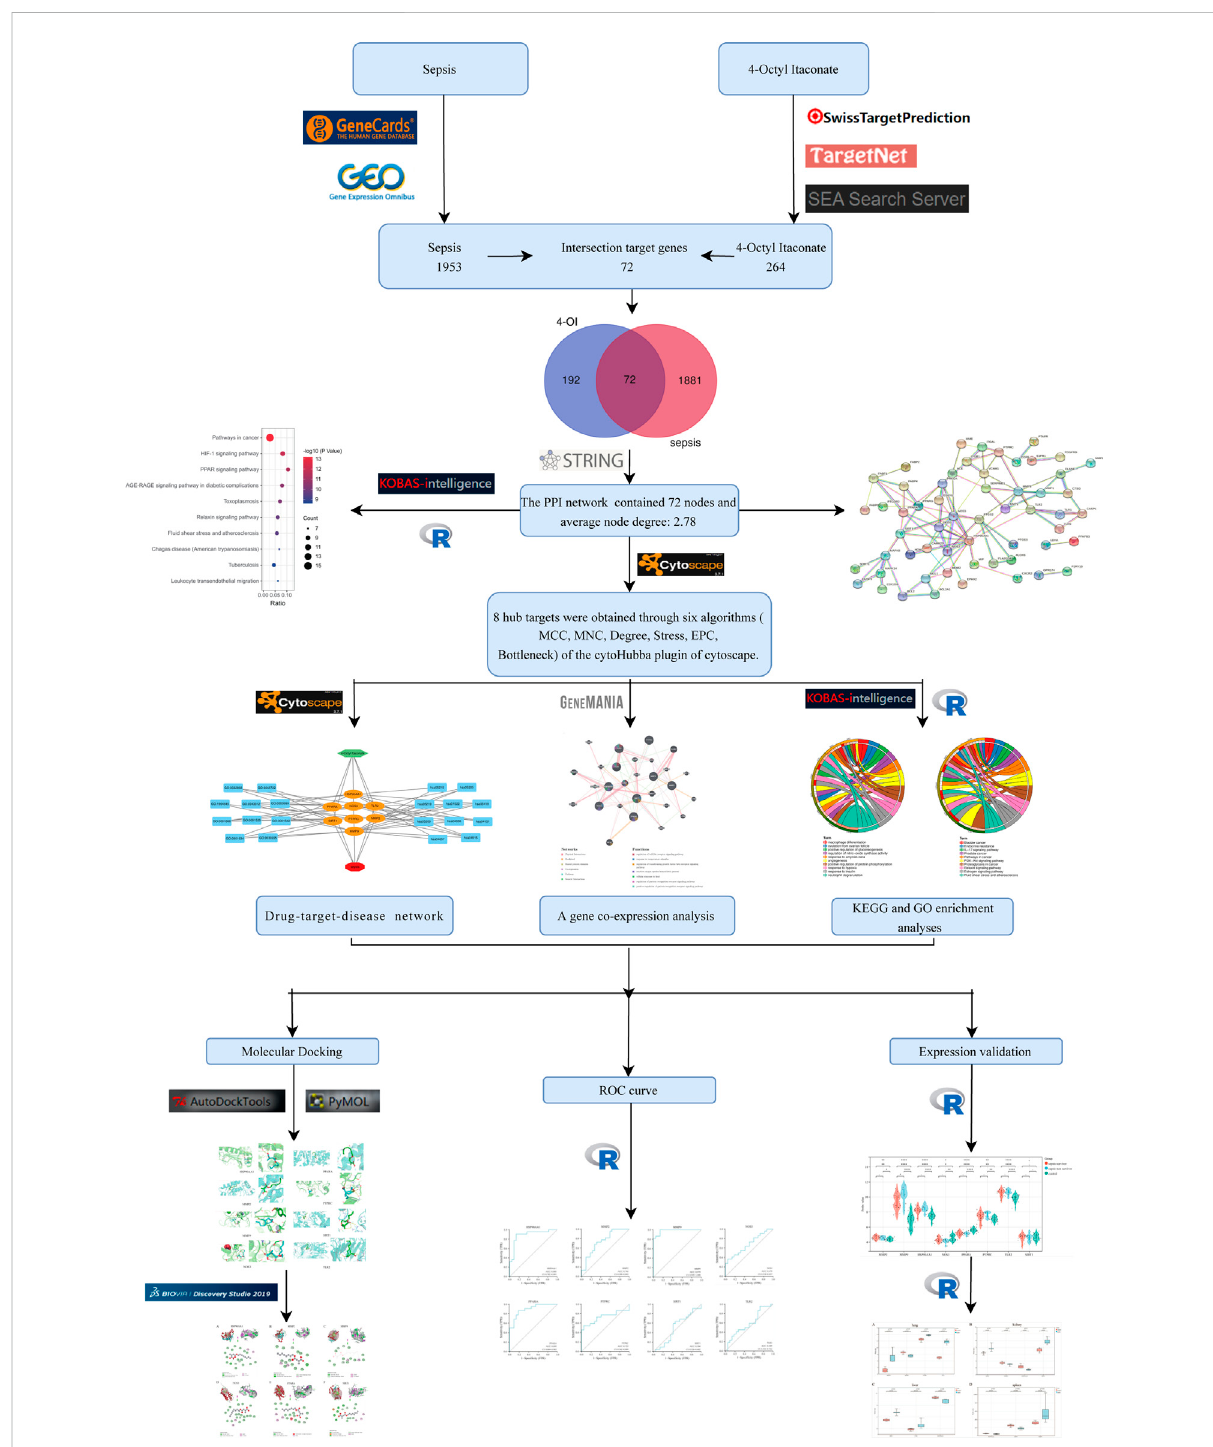
FIGURE 1 The design fl ow chart of this